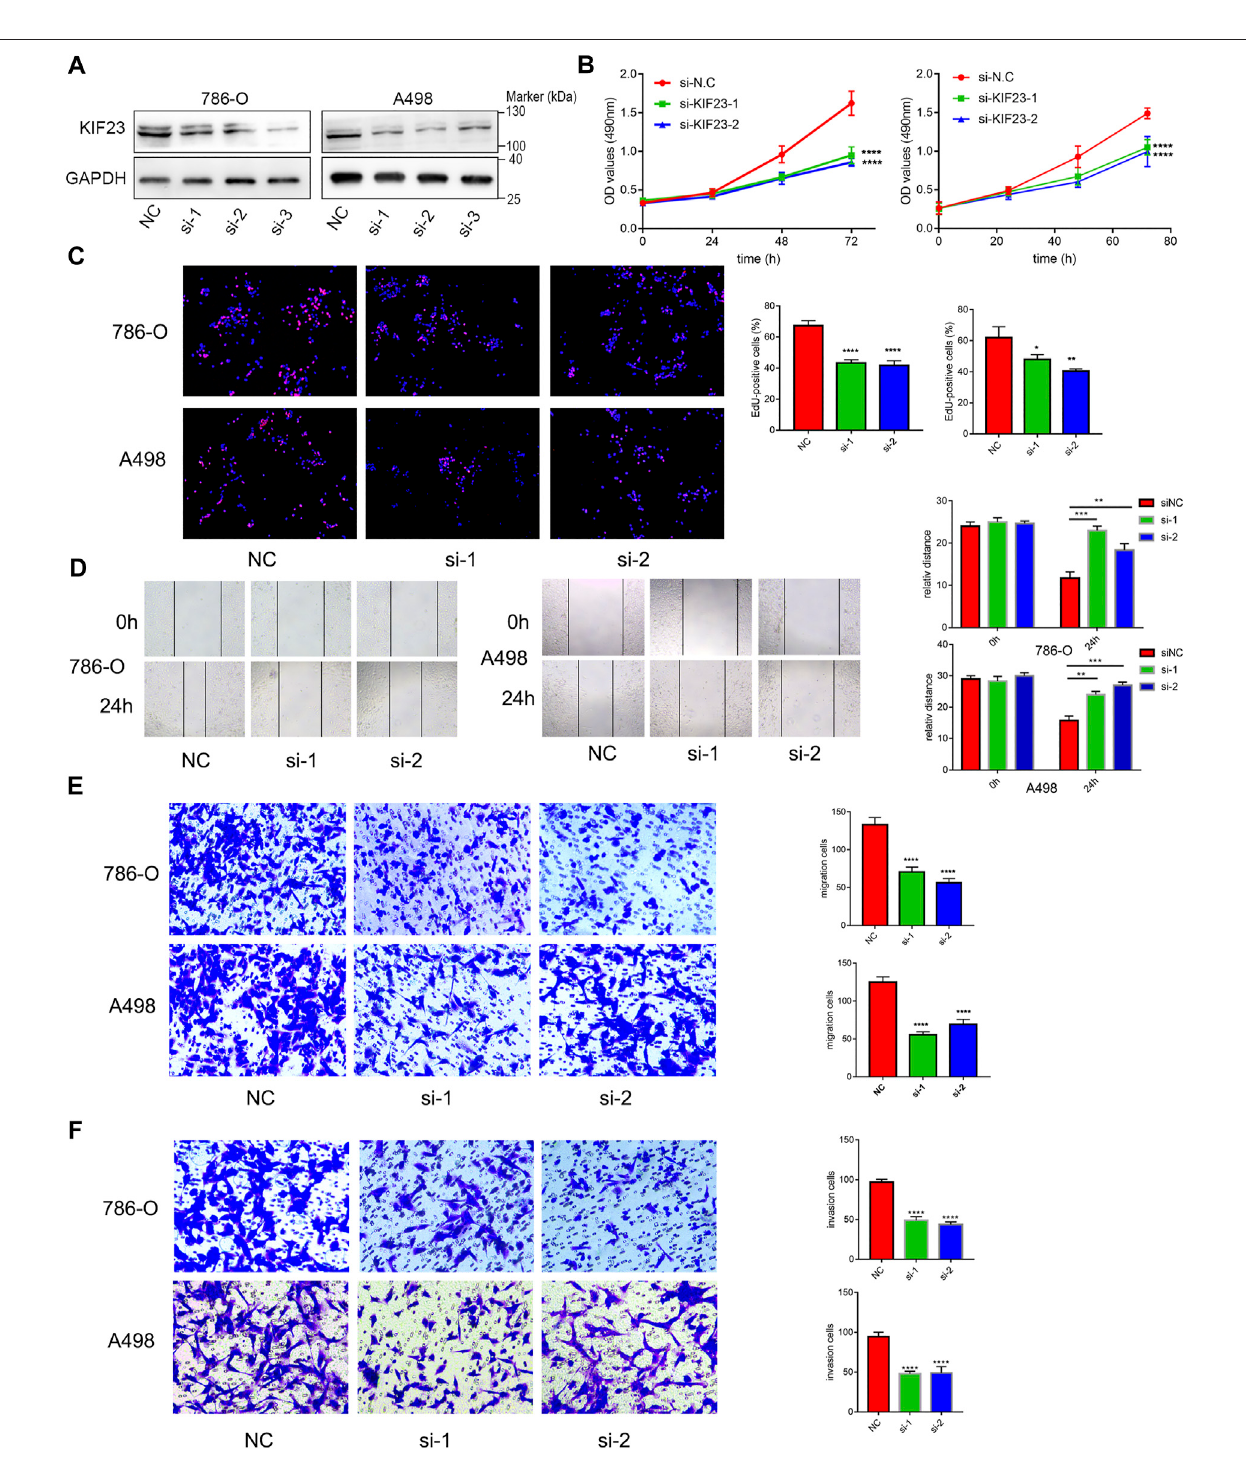
FIGURE 9 | KIF23 promotes proliferation, migration and invasion of ccRCC cells. (A) Protein expression levels of KIF23 in 786-O and A498 cells following siRNA interference. (B,C) CCK-8, EdU assays. (D – F) Wound-healing, transwell migration and invasion assays.